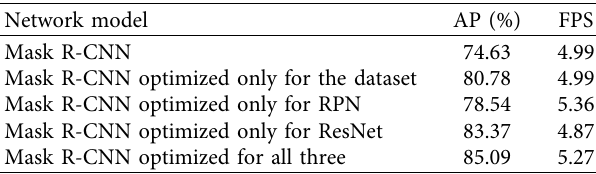
Table 3: Algorithm optimization and comparison experiment results.